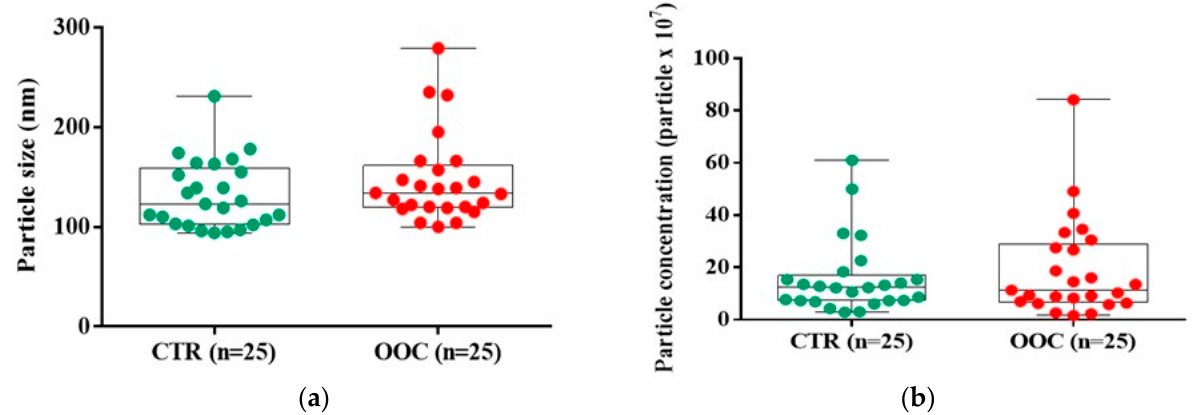
Figure 1. Characterization of salivary ‐ derived exosomes isolated from healthy and cancer groups through ultracentrifugation. ( a ) Size distribution profiles of exosomes were determined based on their Brownian motion using NanoSight. ( b ) The concentration of salivary ‐ derived exosomes based on the particle concentration (particles × 107). Data were analyzed using Mann ‐ Whitney ‐ Wilcoxon rank sum test. The miRs identification and expression level.